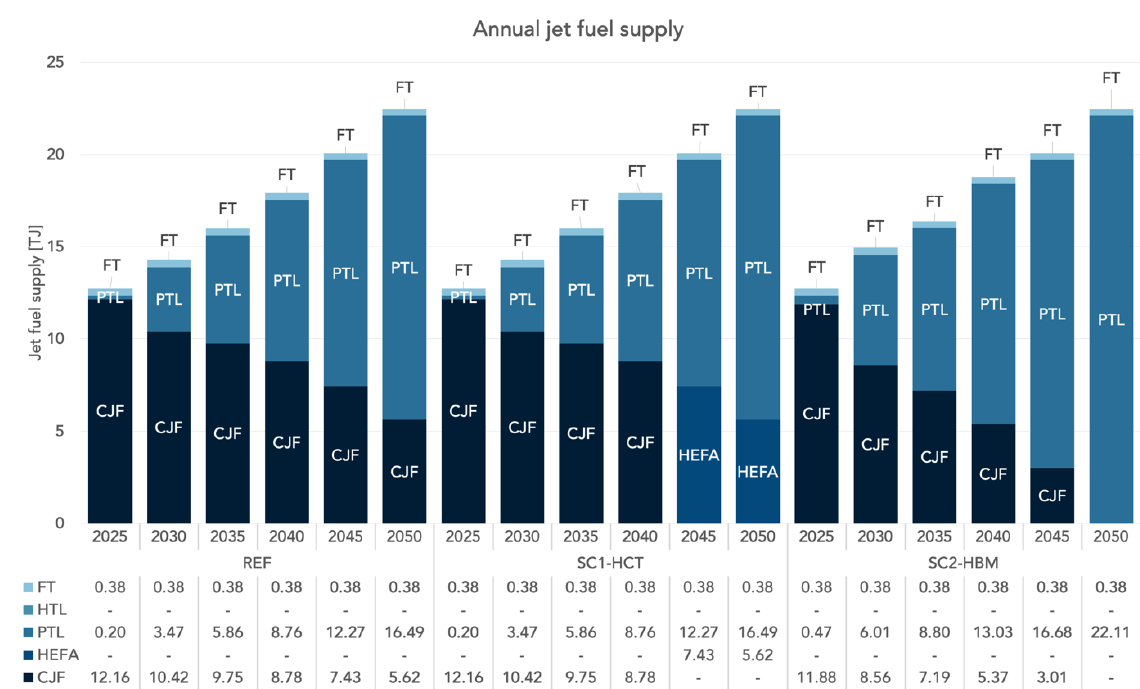
Figure 7. Annual jet fuel supply in scenarios REF, SC1-HCT and SC2-HBM with different policy configurations for 2025 – 2050. REF (Reference scenario); SC1-HCT (Higher carbon tax); SC2-HBM (Higher blending mandate. FT (Fischer–Tropsch); HTL (Hydrothermal liquefaction); PTL (Power-to-liquid); CJF (Conventional jet fuel); HEFA (Hydroprocessed esters and fatty acids).